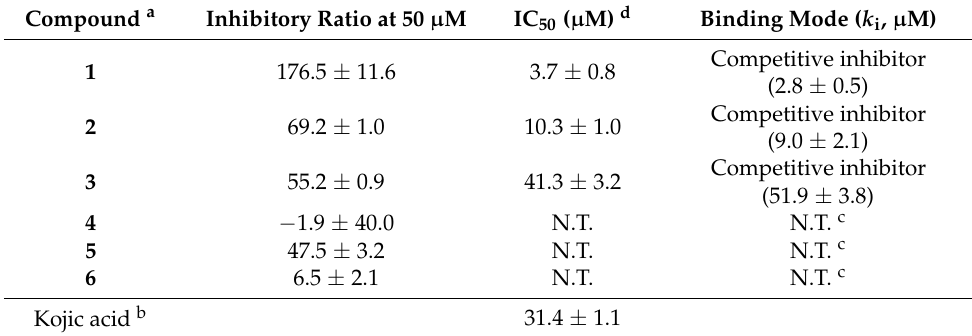
Figure 1. The structures of compounds 1 – 6 . Table 1. Inhibitory activity of compounds 1 – 6 on tyrosinase. Table 1. Inhibitory activity of compounds 1 – 6 on